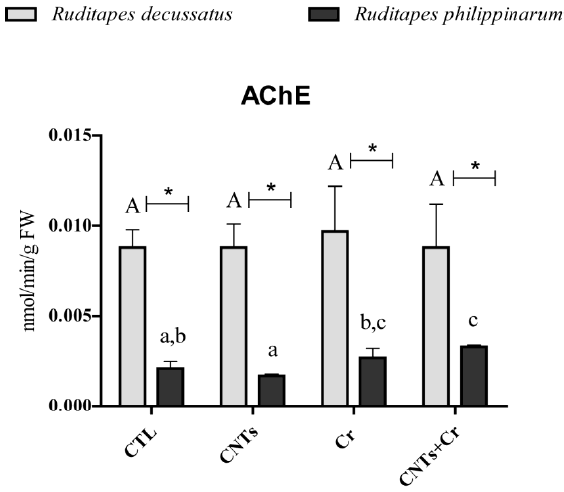
Figure 5. Acetylcholinesterase (AChE) activity (mean values+ standard deviation), in Ruditapes decussatus (light gray bars) and Ruditapes philippinarum (dark gray bars) after a 28-day exposure period. For each species, tested treatments were: control (CTL), carbon nanotubes (CNTs), chromium (Cr), and the combination of both contaminants (CNTs + Cr). Significant differences ( p < 0.05) among treatments are represented with different letters (lowercase for R. decussatus and uppercase for R. philippinarum ). For each treatment, significant differences ( p < 0.05) between R. decussatus and R. philippinarum are represented with an asterisk (*).